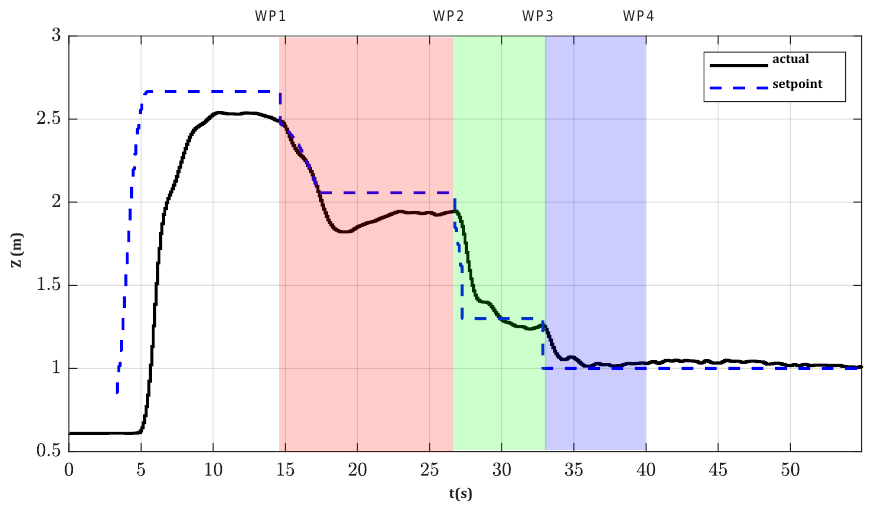
Figure 9. Z -axis motion during one of the trials.